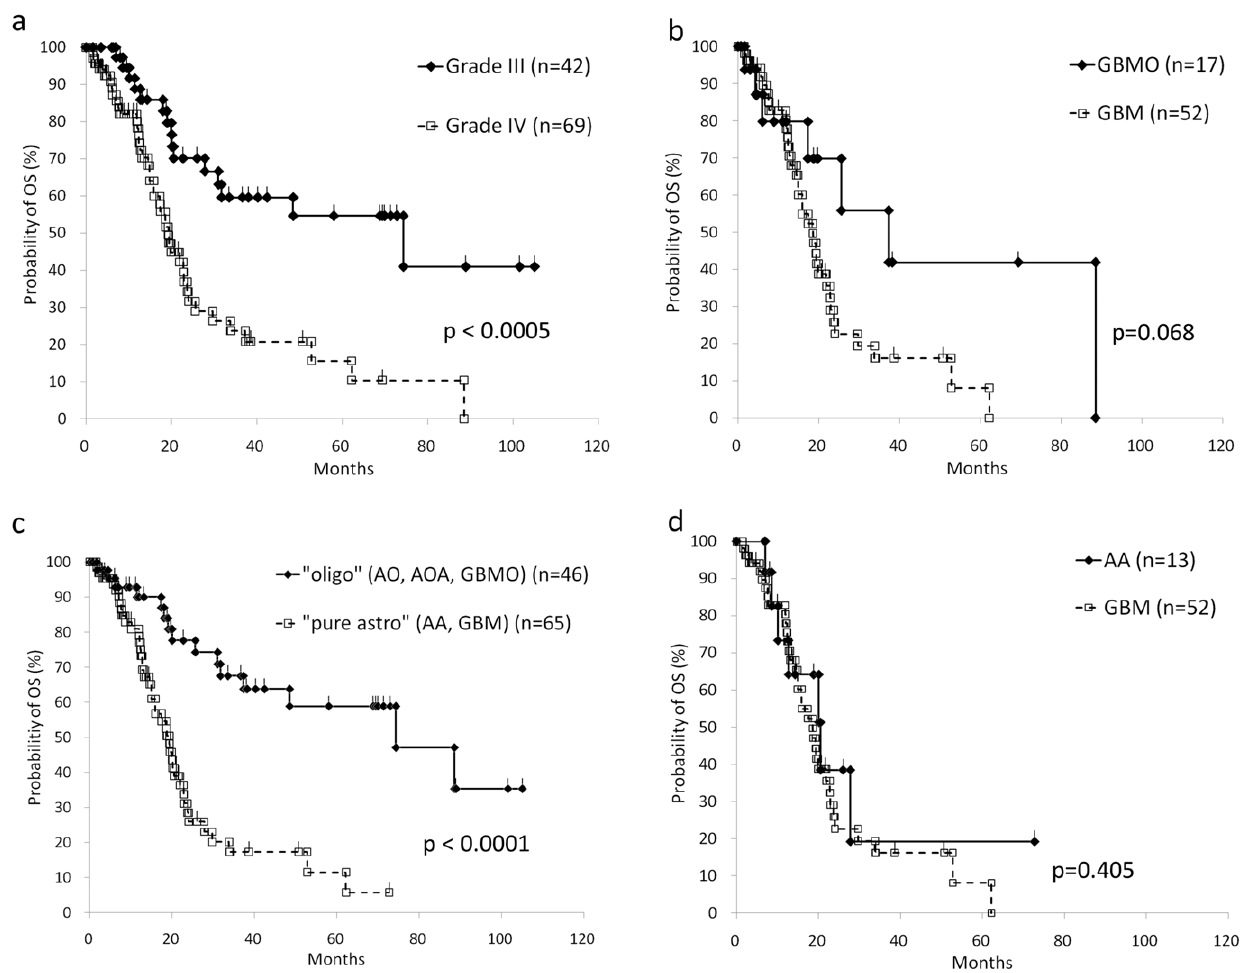
Figure 2. Overall survival (OS) analysis based on the histological subclassifications. a: Conventional Grade III gliomas (AA, AO and AOA) show significantly better prognosis than Grade IV gliomas (GBM, GBMO). b: GBMO presented longer survival compared to GBM, although it is statistically not significant (p=0.068). c: Oligodendroglial tumor (‘‘oligo’’; AO, AOA, GBMO) shows significantly better prognosis compared to pure astrocytic tumor (‘‘pure astro’’; AA, GBM). d: The survival curve of AA patients is almost identical to that of GBM patients.